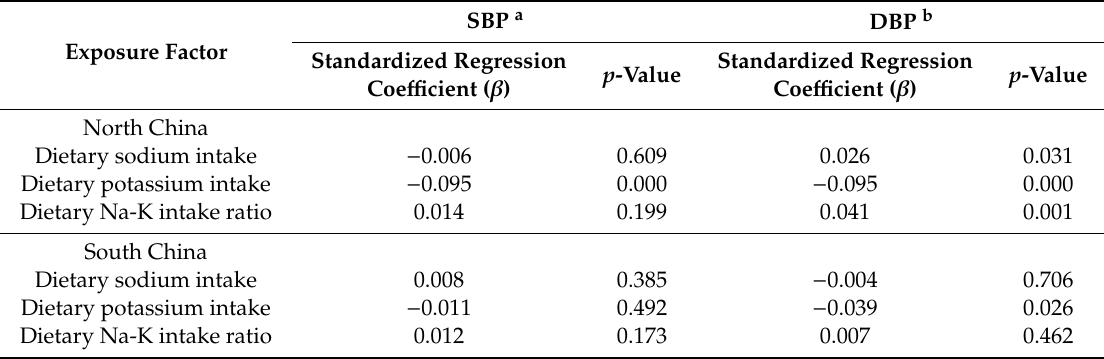
Table 2. Multiple linear regression analysis of blood pressure with dietary sodium, potassium, and Na-K ratio by regions.